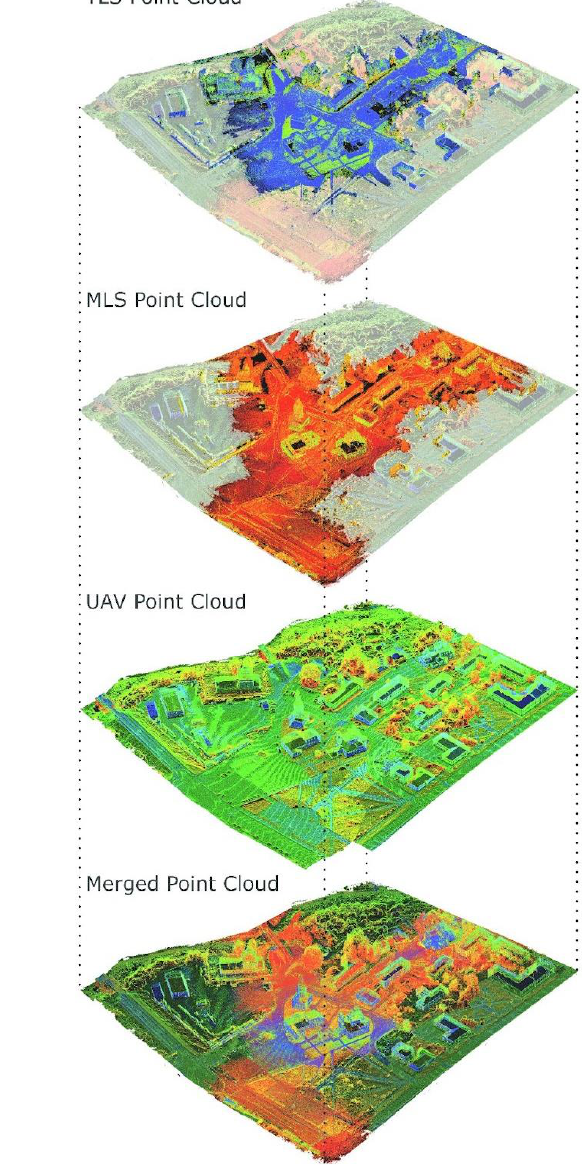
Figure 4 . Multi-source urban digital data: complementarity comparison between the referenced instrumental datasets.